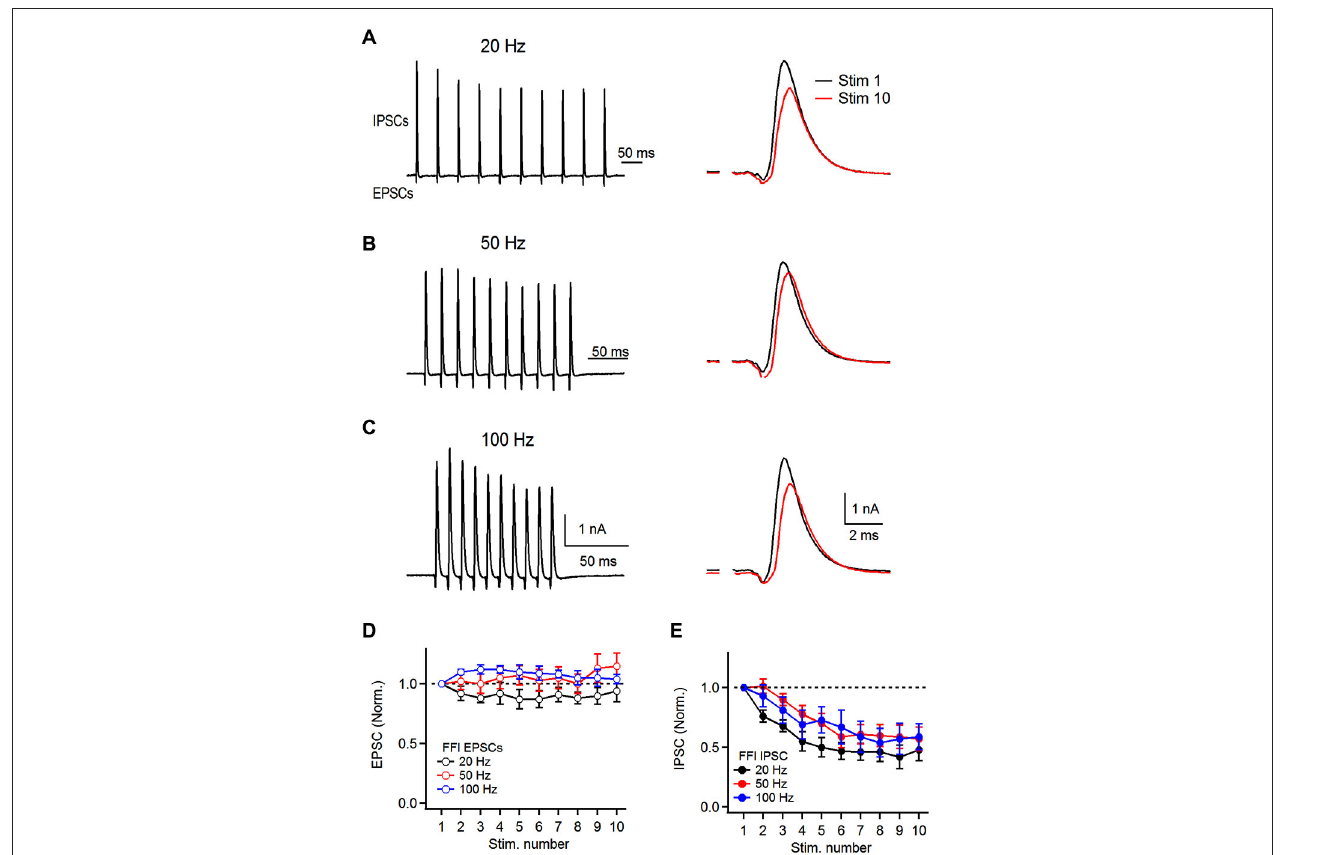
the right. (B,C) Recordings of feed-forward inhibition in FCs at 50 and 100 Hz. (D) Plot of EPSC short-term plasticity in the EPSC-IPSC sequence at 20, 50 and 100 Hz. Amplitudes were normalized to the first EPSC in the train. (E) Plot of IPSC short-term plasticity during FFI trials at 20, 50 and 100 Hz showing pronounced depression. IPSCs were normalized to the first PSC in the train (B and C , n = 6